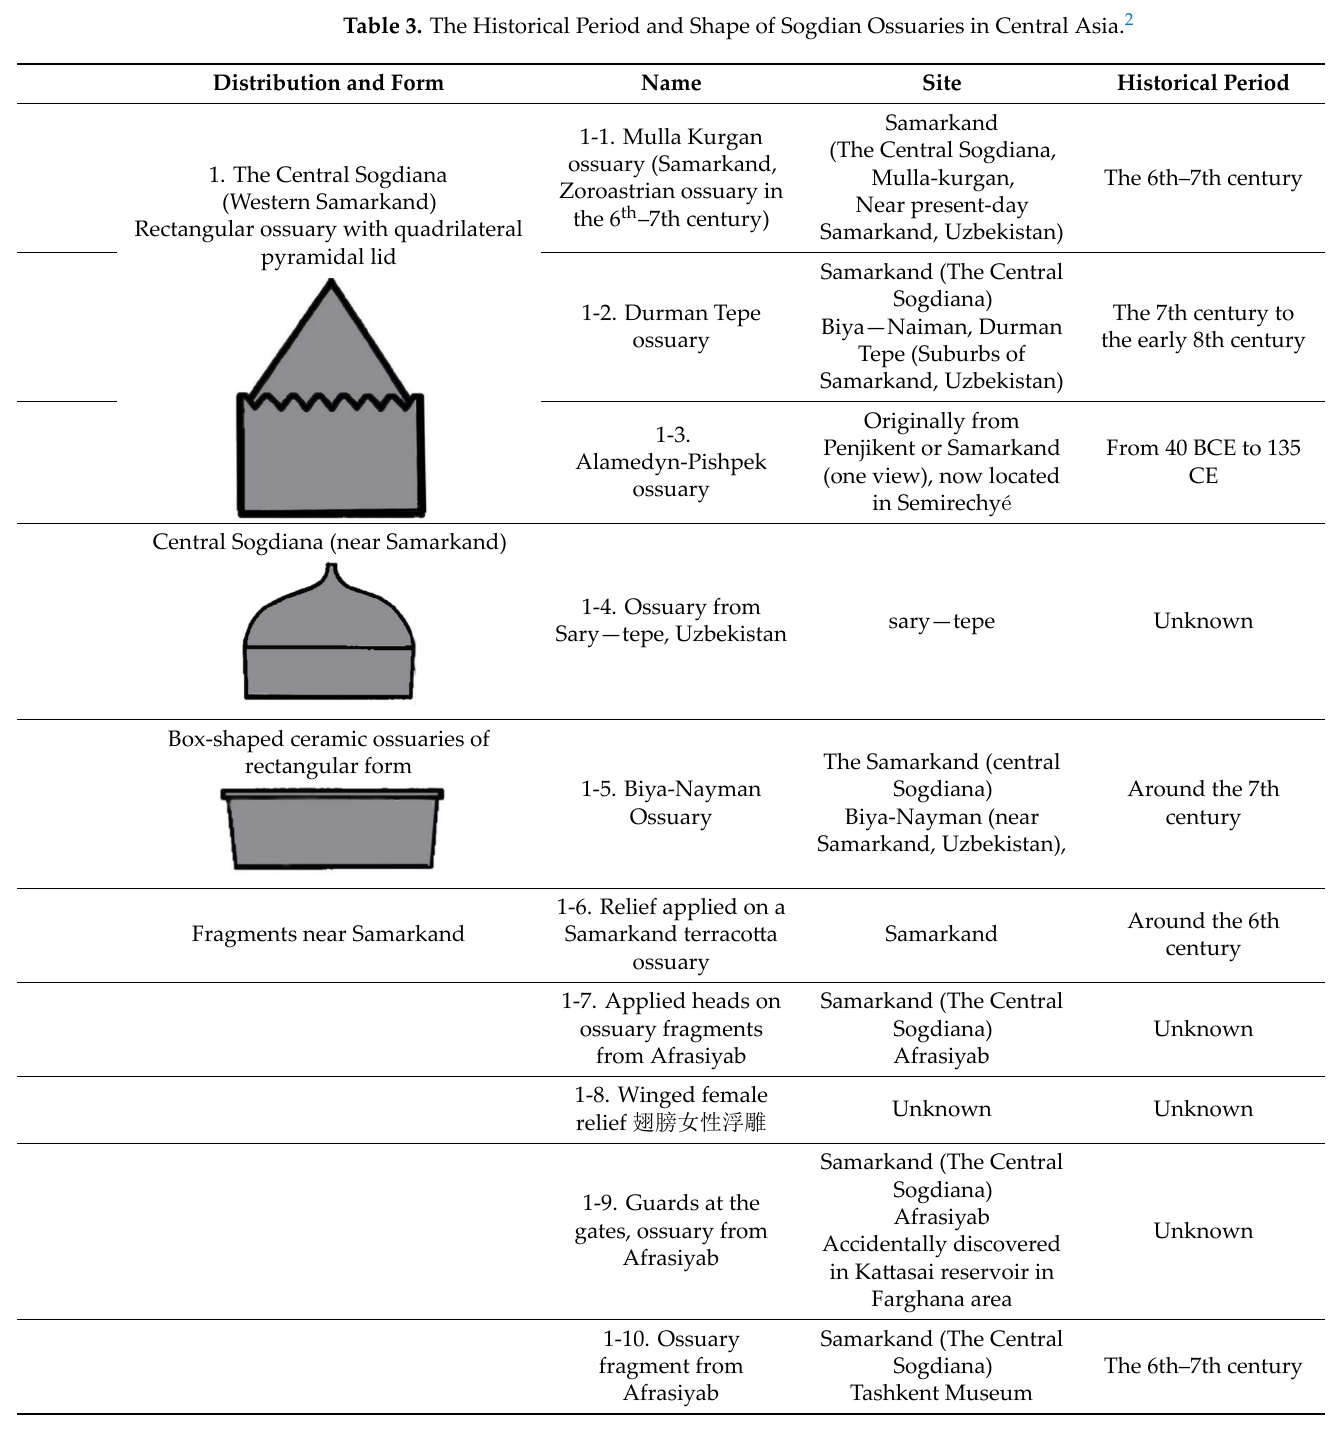
Table 3. The Historical Period and Shape of Sogdian Ossuaries in Central Asia. 2 Distribution and